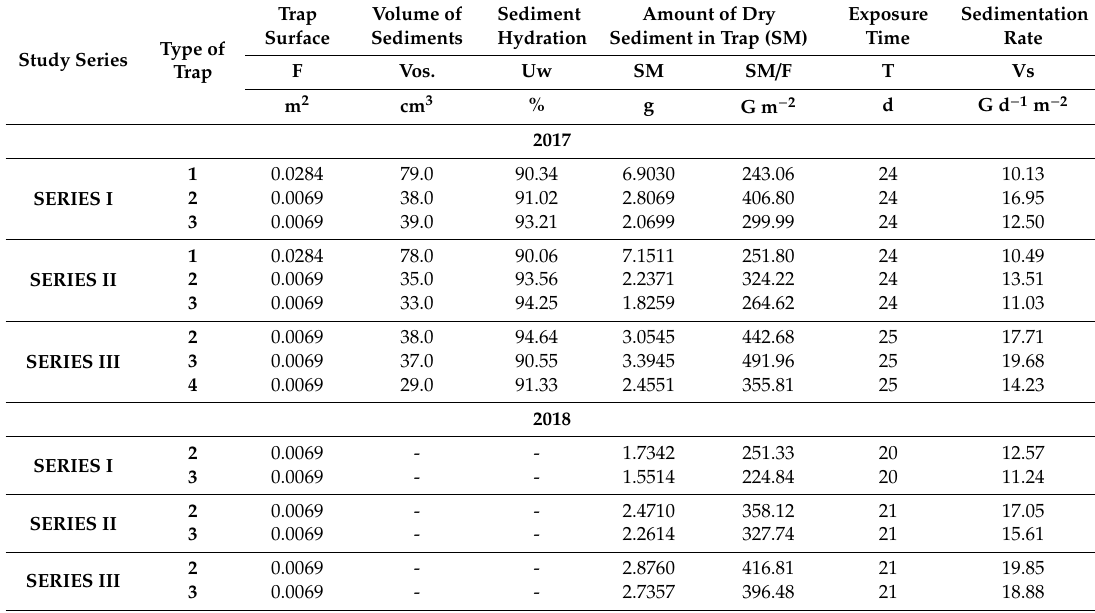
Table 5. Comparison of the study results characterizing retained matter and sedimentation